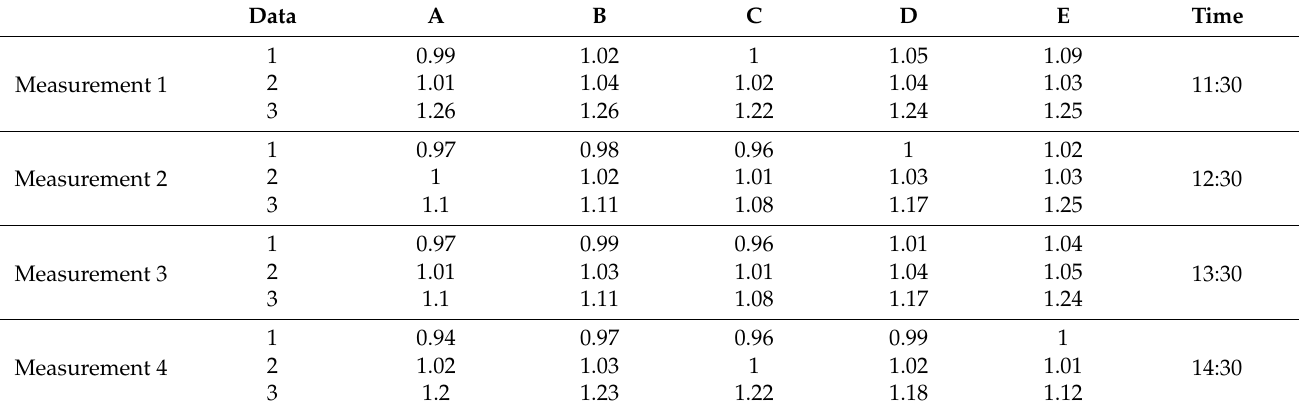
Table 5. Radiation ratios with galvanized steel canal and side panels with aluminum mirror